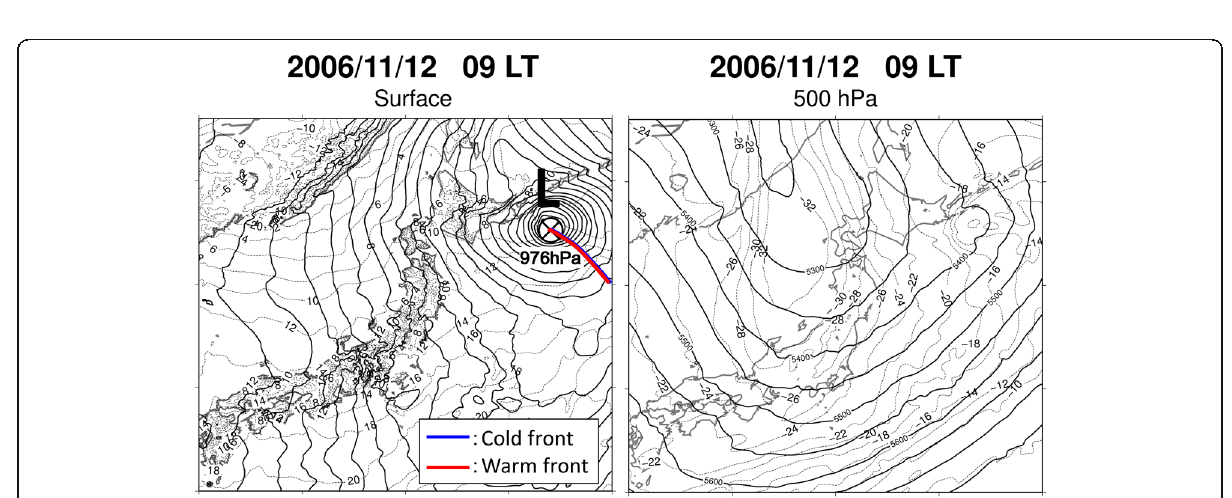
Fig. 17 Atmospheric conditions on 11 November 9 LT, 2006. Sea-level pressure (hPa) (geopotential height (m) at the 500 hPa pressure level) and air temperature distribution